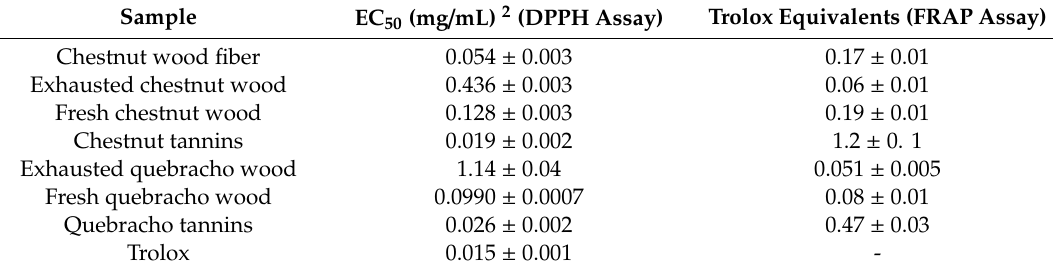
Table 1. Antioxidant properties of tannins and wood samples.